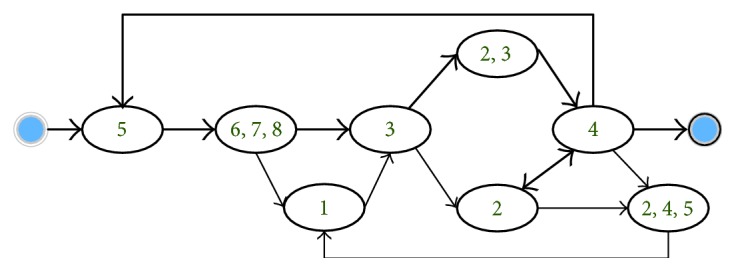
ICH process model.